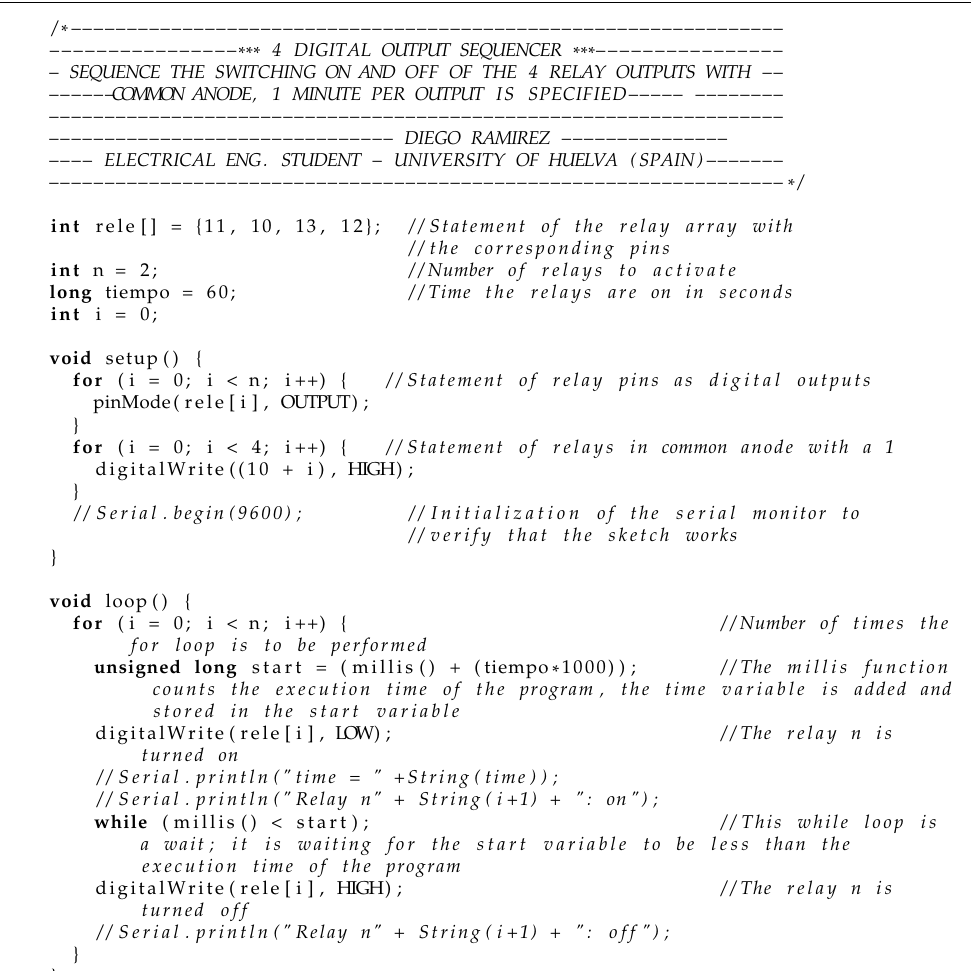
Algorithm A1: The Arduino code is detailed below